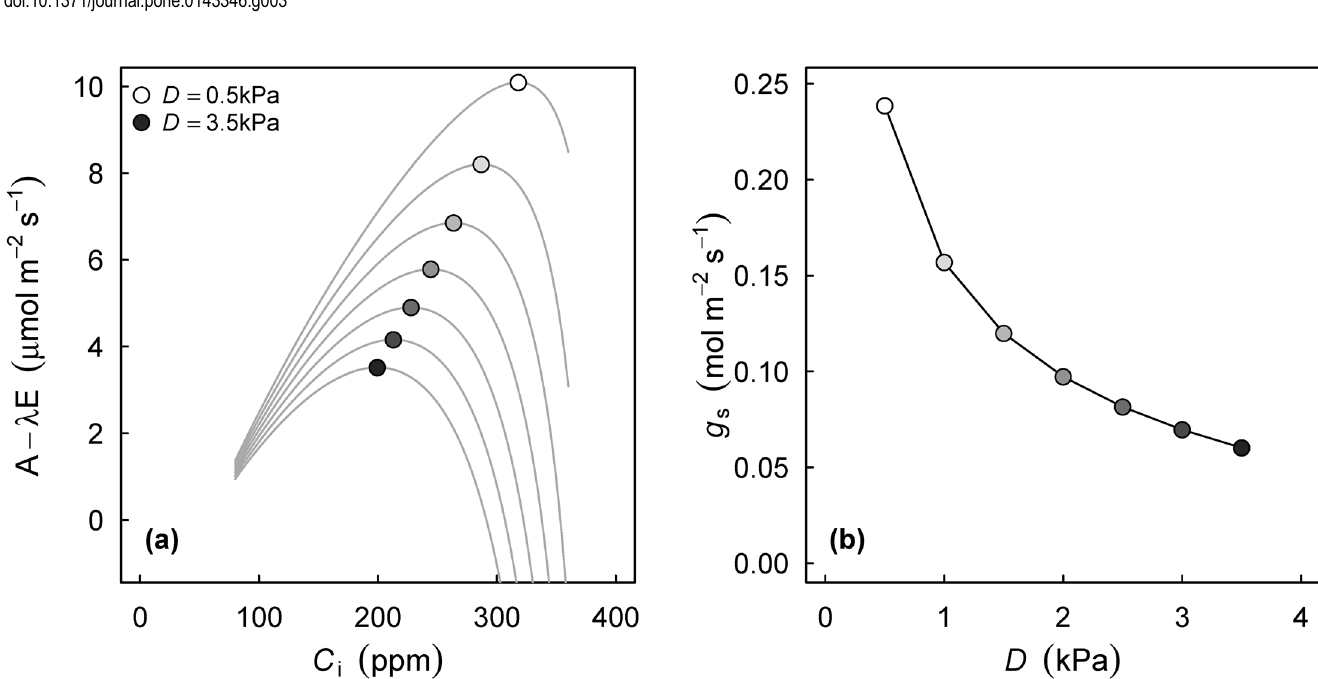
Fig 4. Visualization of the optimal model of stomatal conductance. Provided we have an estimate of the 'cost of water' ( λ , mol C mol H 2 O -1 ), stomata act to maximize photosynthesis minus transpiration. In (A), individual curves at a range of values for the vapour pressure deficit (D) are plots of A − λ E as a function of C i , demonstrating that an optimum C i exists. The FARAO function finds this optimum numerically and calculates corresponding A n and g s . The corresponding response of g s to D is shown in panel (B).